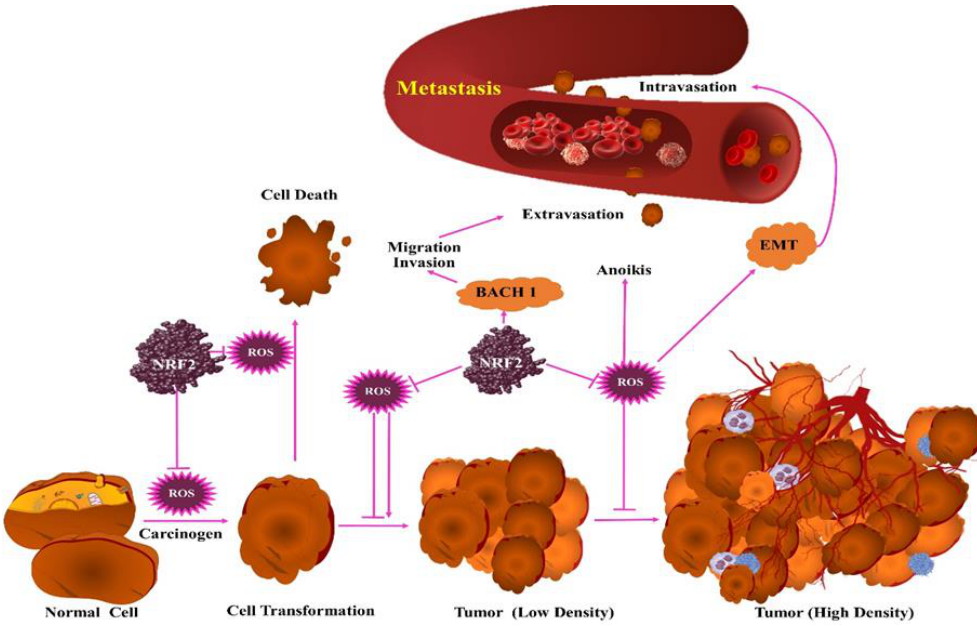
Figure 3. Role of NRF2 at various of cancer stages.